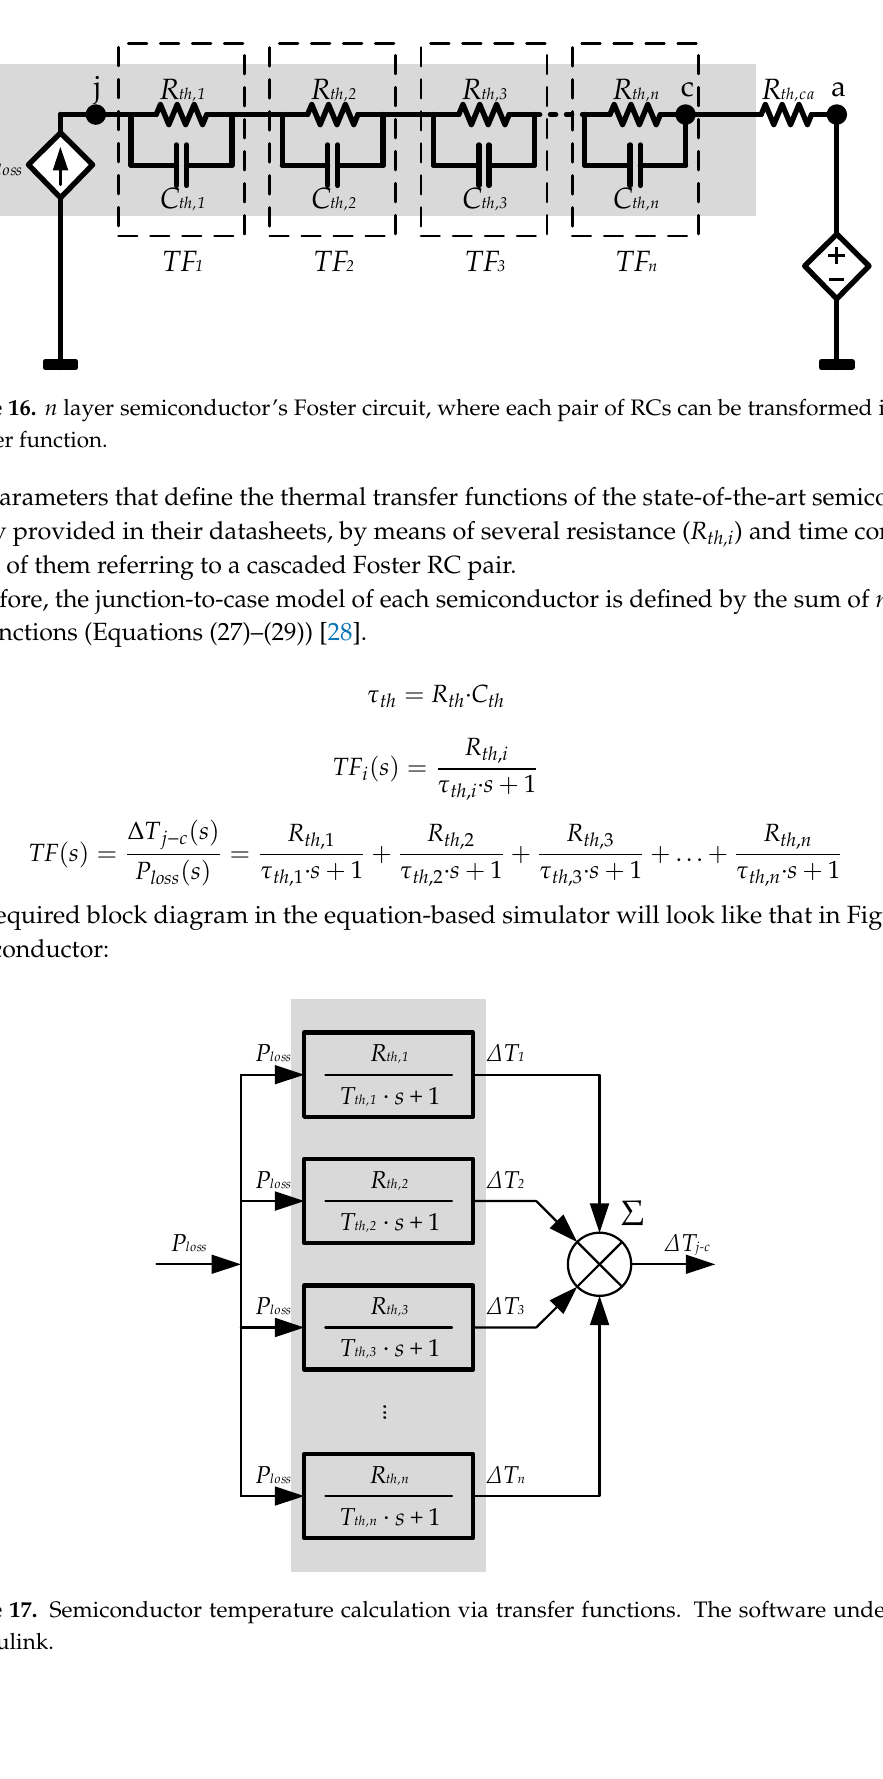
Figure 15. Equivalent thermal circuit of the two level three-phase inverter, where each semiconductor Foster circuit is marked with a grey area.